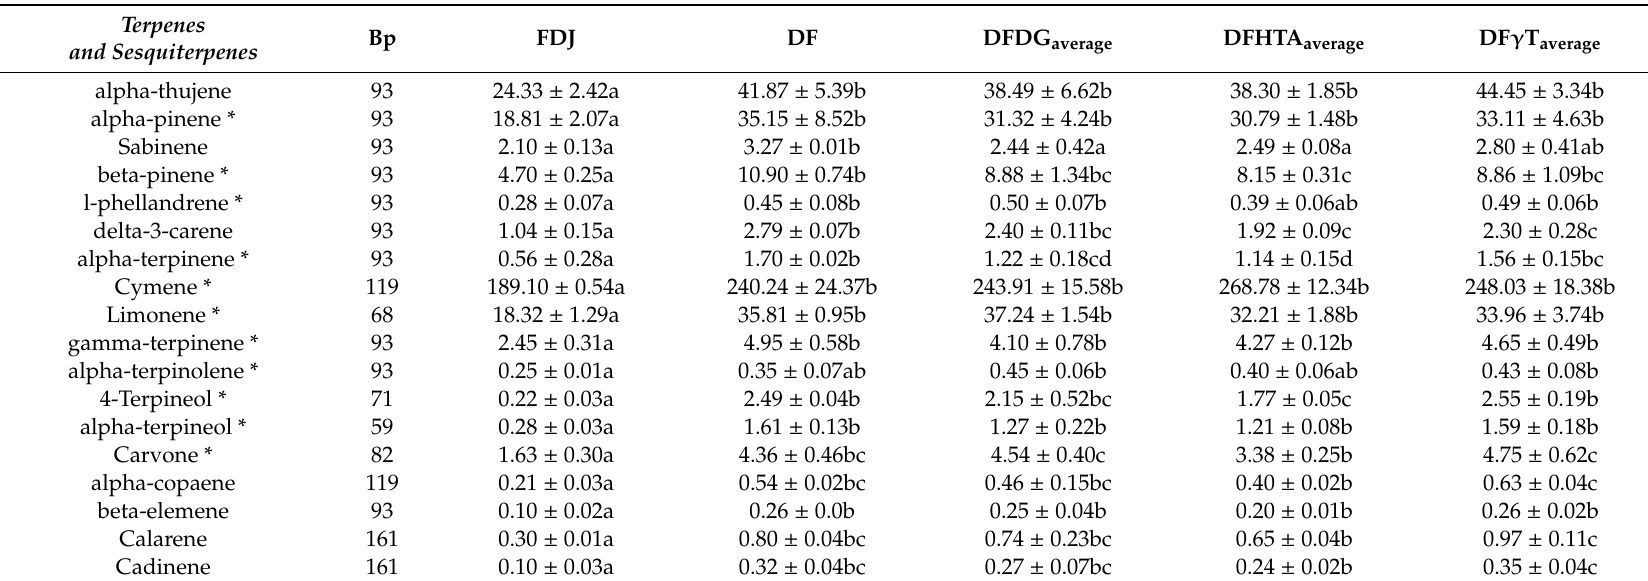
Table 5. Terpenes and sesquiterpenes of virgin flaxseed oil, detected by SPME-GC / MS in the headspaces of the mixture of digestive juices submitted to digestive conditions and virgin flaxseed oil FDJ, of the digestate of this oil DF and of the digestates of the samples enriched with di ff erent levels of dodecyl gallate, hydroxytyrosol acetate, and gamma-tocopherol (DFDG, DFHTA, DF γ T). Data are average abundances expressed as area counts of the mass spectra base peak Bp of each compound multiplied by 10 − 6 , together with their standard deviations. For samples enriched with phenolic compounds, data given are average values of the abundances of the headspace of digestates coming from samples having di ff erent enrichment levels of phenolic